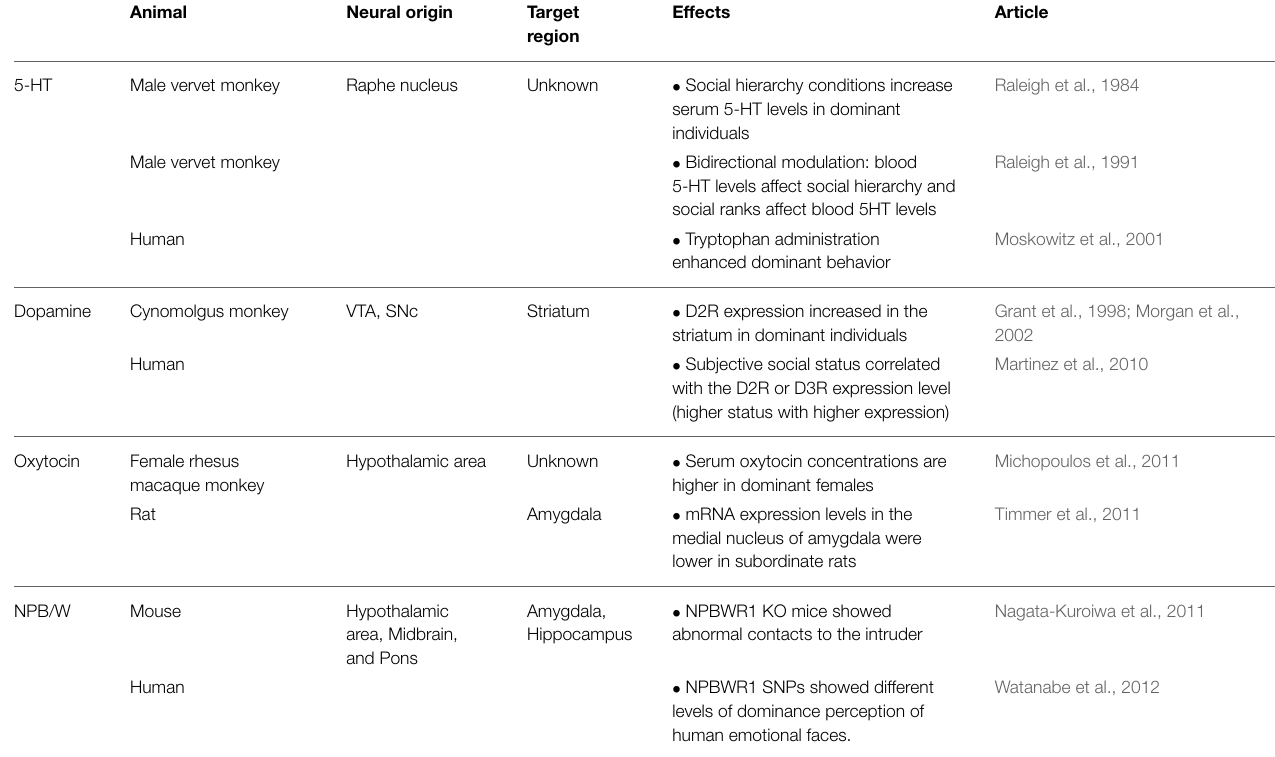
TABLE 2 | Neurotransmitters and hormones that influence social dominance.